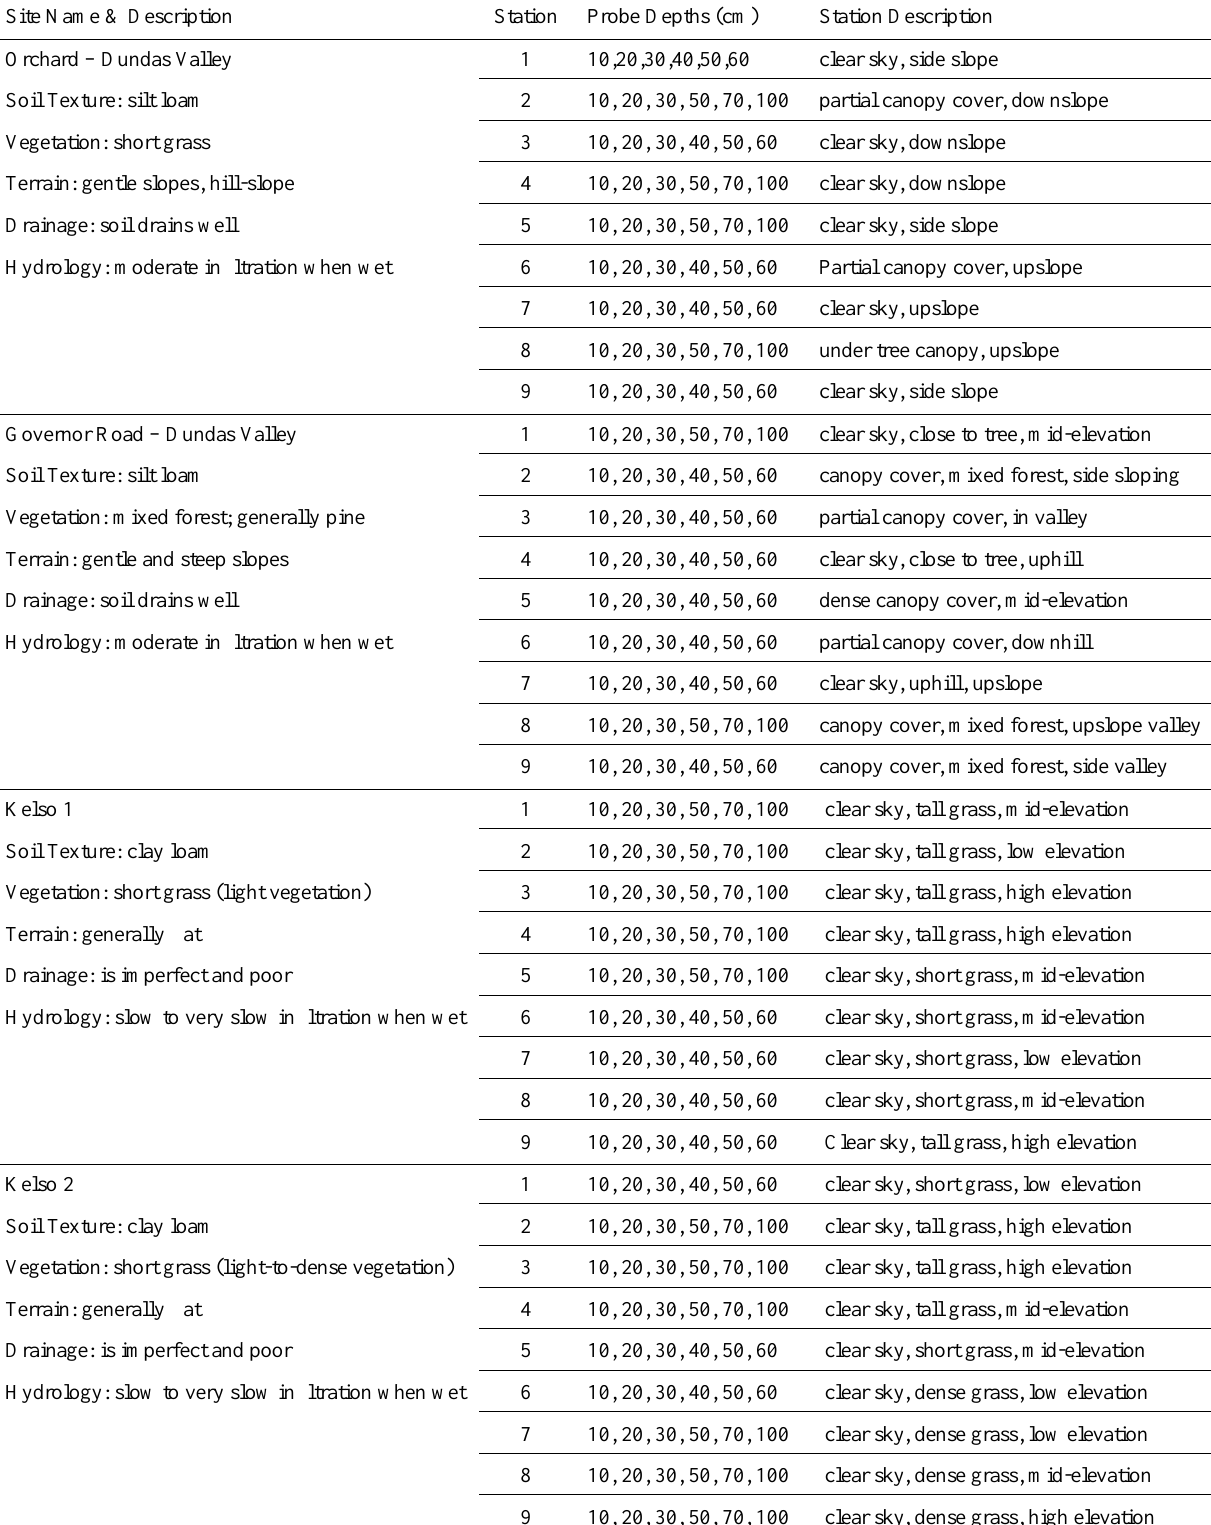
Table 2. McMaster Mesonet site and station